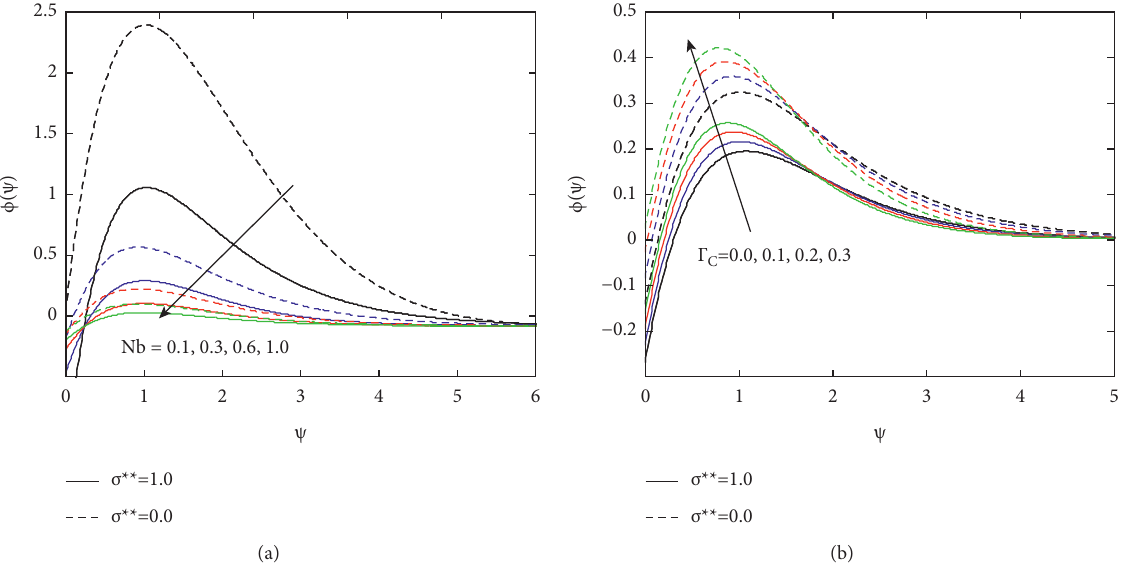
Figure 8: The nanofluid concentration distribution for diverse quantity of Nb (a) and Γ